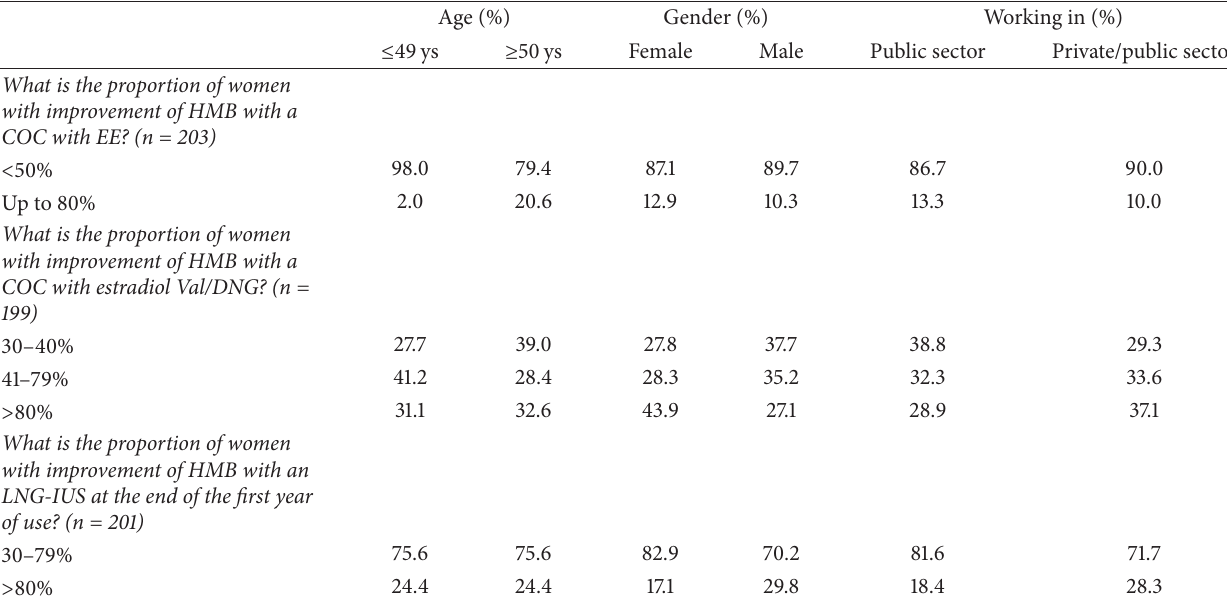
Table 2: Answers provided by the OBGYNs regarding some therapeutic aspects of heavy menstrual bleeding